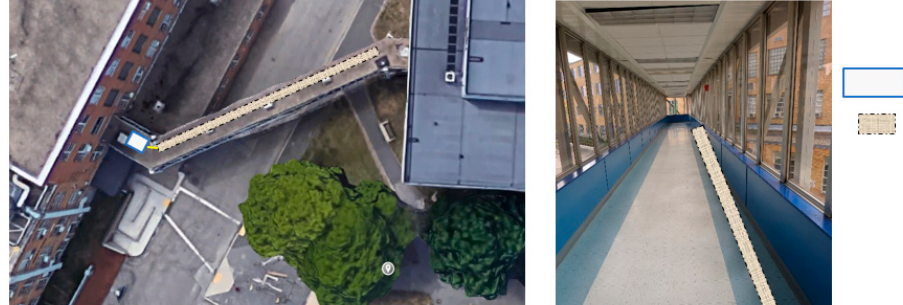
Figure 4. Location of installation.